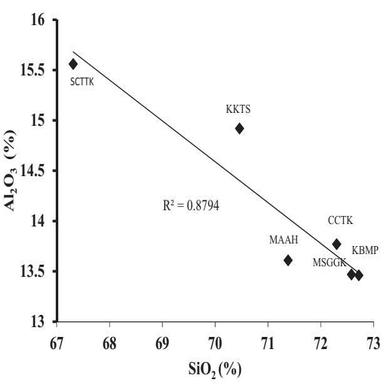
Linear relationship between SiO2 and Al2O3.